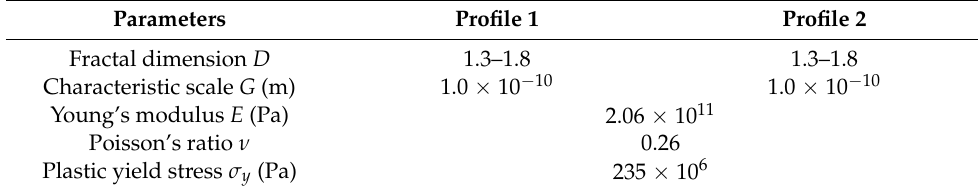
Table 1. Calculated parameters for the mechanical properties of rough